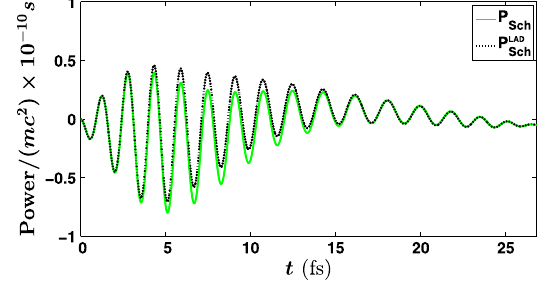
FIG. 14. Transverse velocity u x =c plotted vs time t for a sinusoidal-envelope circularly polarized laser pulse with param- eters given in Fig. 12.